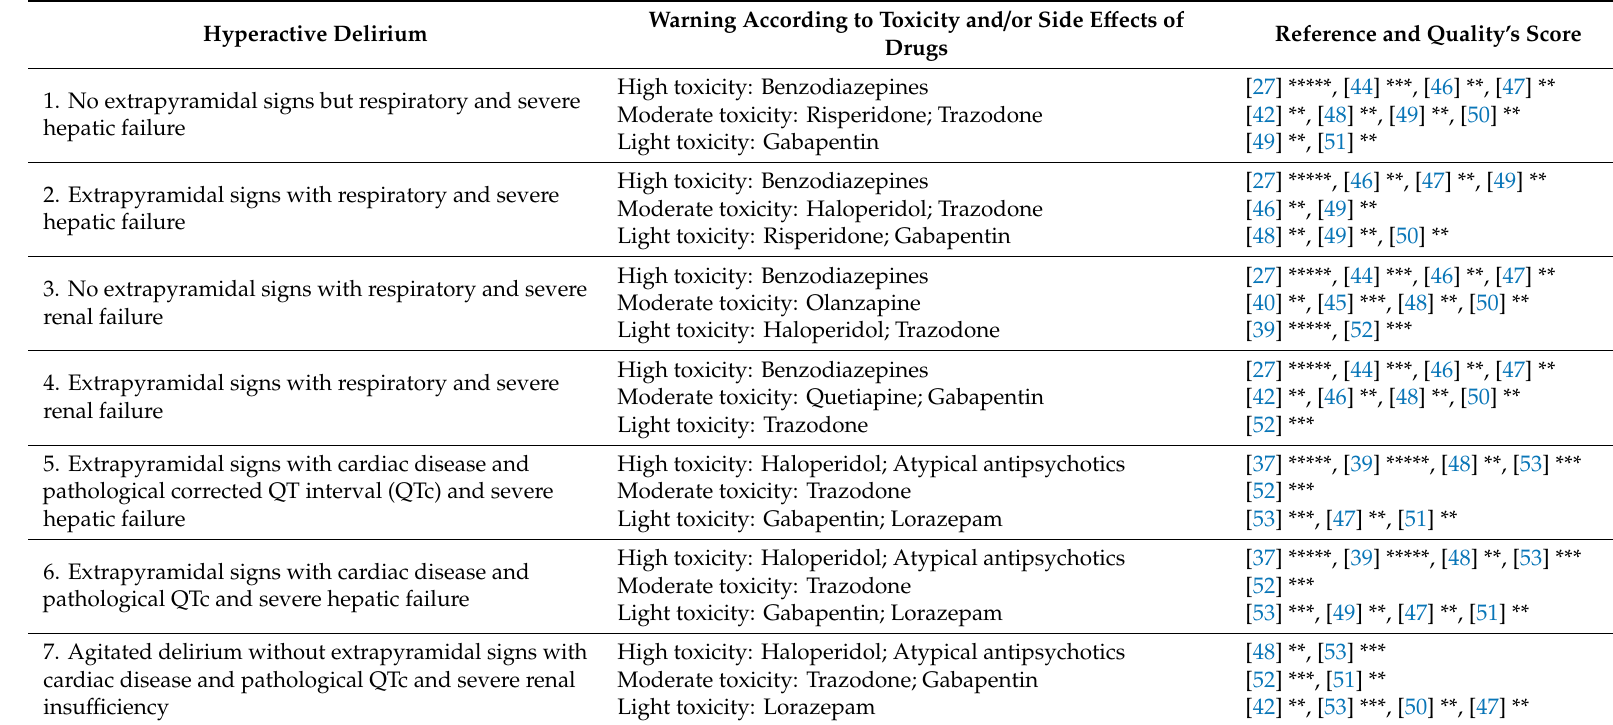
Table 1. Warning for the utilization of psychoactive drugs in agitated delirium due to the fact of their toxicity or side e ff ects. Hyperactive